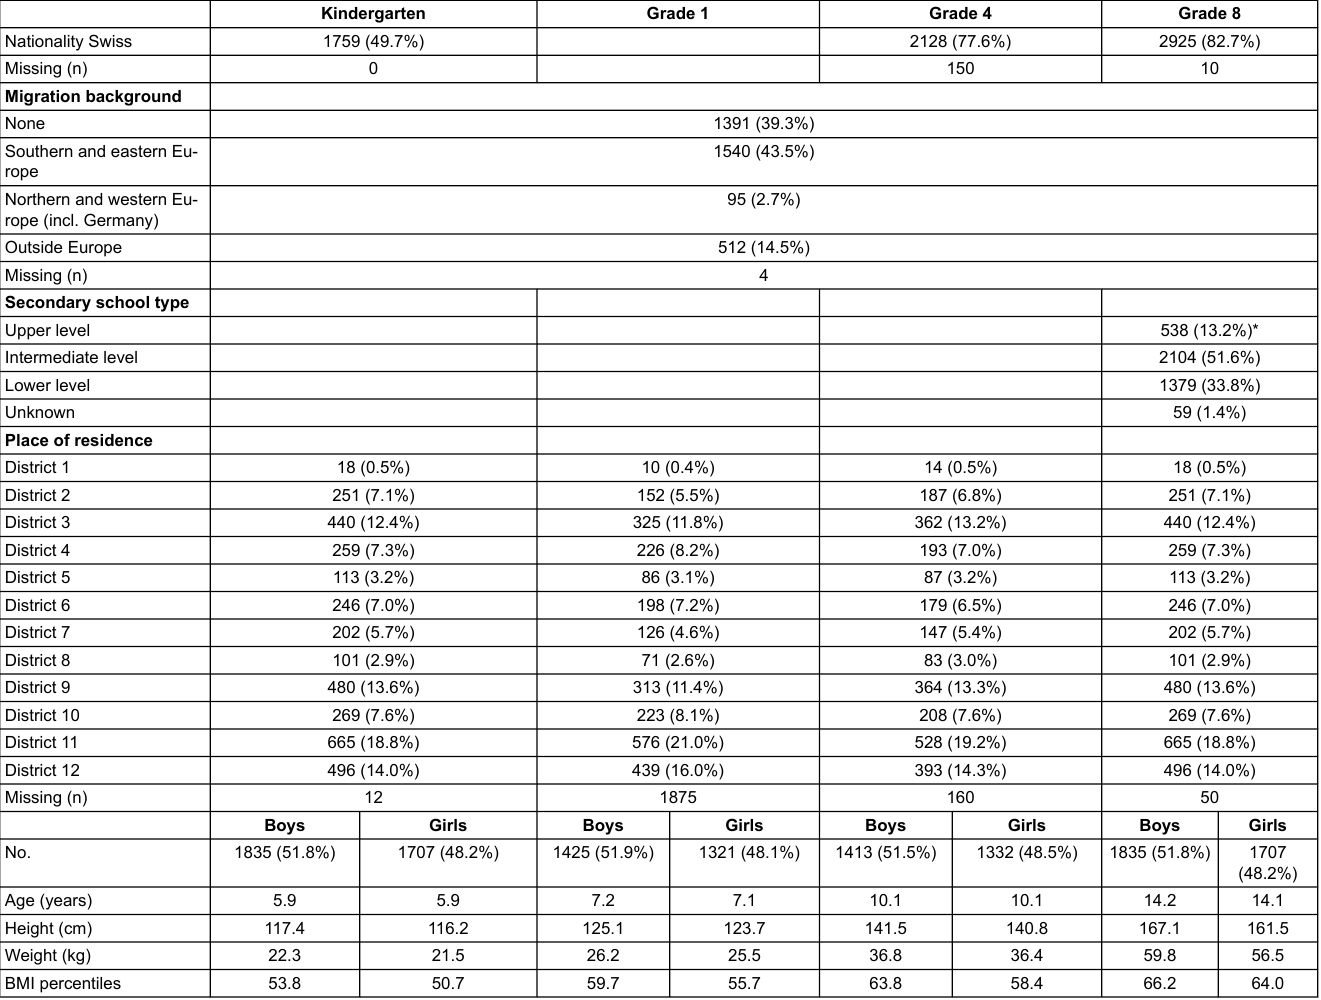
Table S1: Demographic characteristics of the children who participated at least in kindergarten and in grade 8 (n =